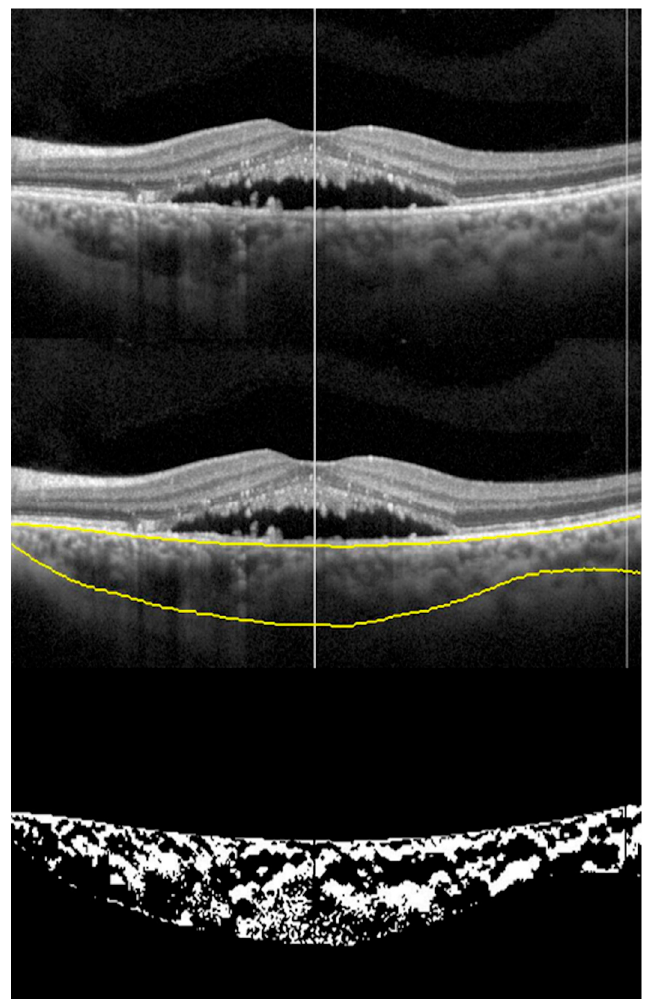
Figure 2. Choroidal vascularity Index (CVI): montage showing the process of CVI calculation. Top scan shows neurosensory detachment in an eye with CSCR; middle scan shows choroidal boundaries using automated algorithm; and bottom scan shows the binarized image of the choroid with CVI of 0.6491.